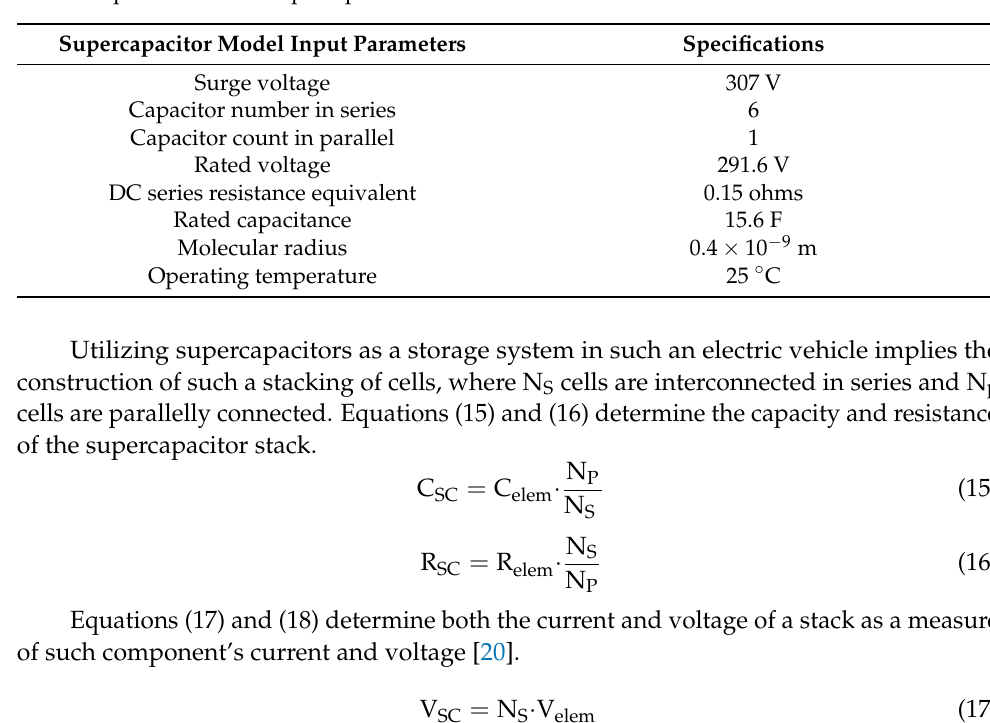
Table 2. Specifications of supercapacitors.